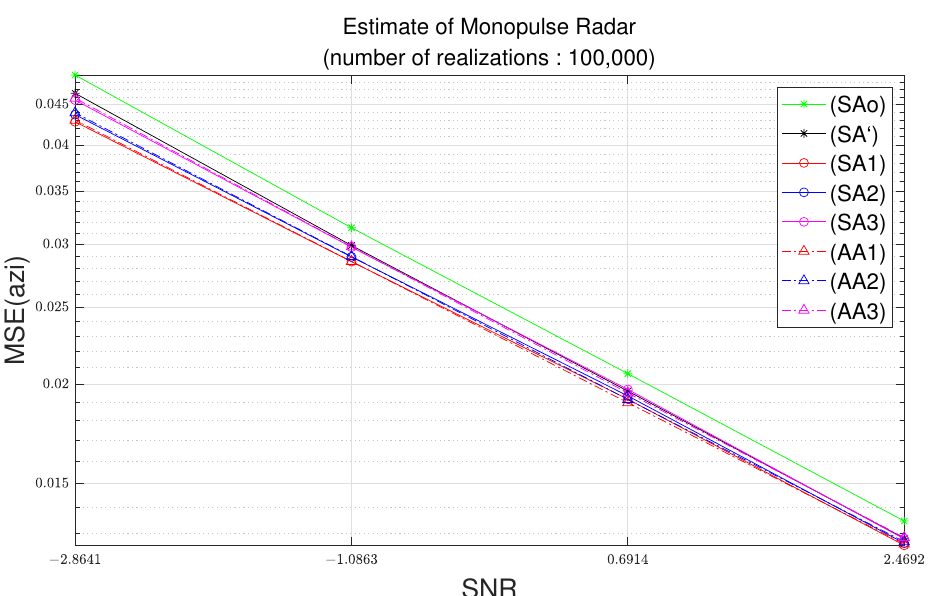
Figure 5. Azimuth MSE as function of SNR with parameters of Table 2 and 100,000 realizations.